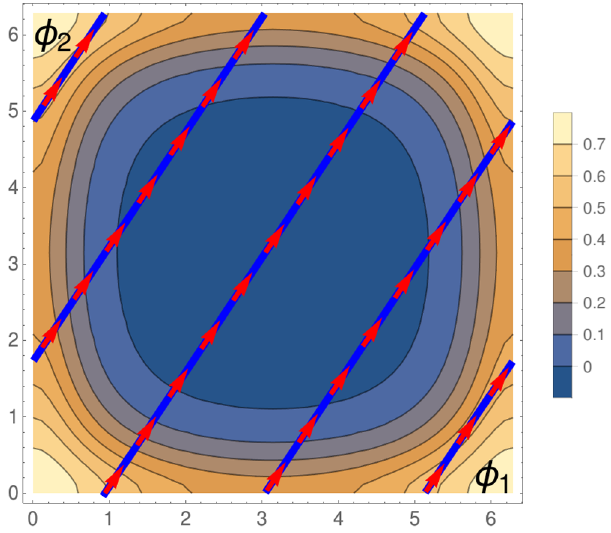
FIG. 3. The Floquet zone for two drives. In analogy to a 2D band structure, we draw the Berry curvature (color plot with side legend) vs the two offset phases φ 1 and φ 2 . The periodic drives are akin to a motion along this Floquet zone with ⃗ φ ¼ ⃗ φ 0 þ ⃗ ω t . In the case of a rational frequency ratio, the system will explore a closed periodic path through the Floquet zone. Drawn here is an example of 3 ω 1 ¼ 2 ω 2 . The pumping effect will be roughly the integral of the Berry curvature along the path times ω ω 1 2 [Eq.